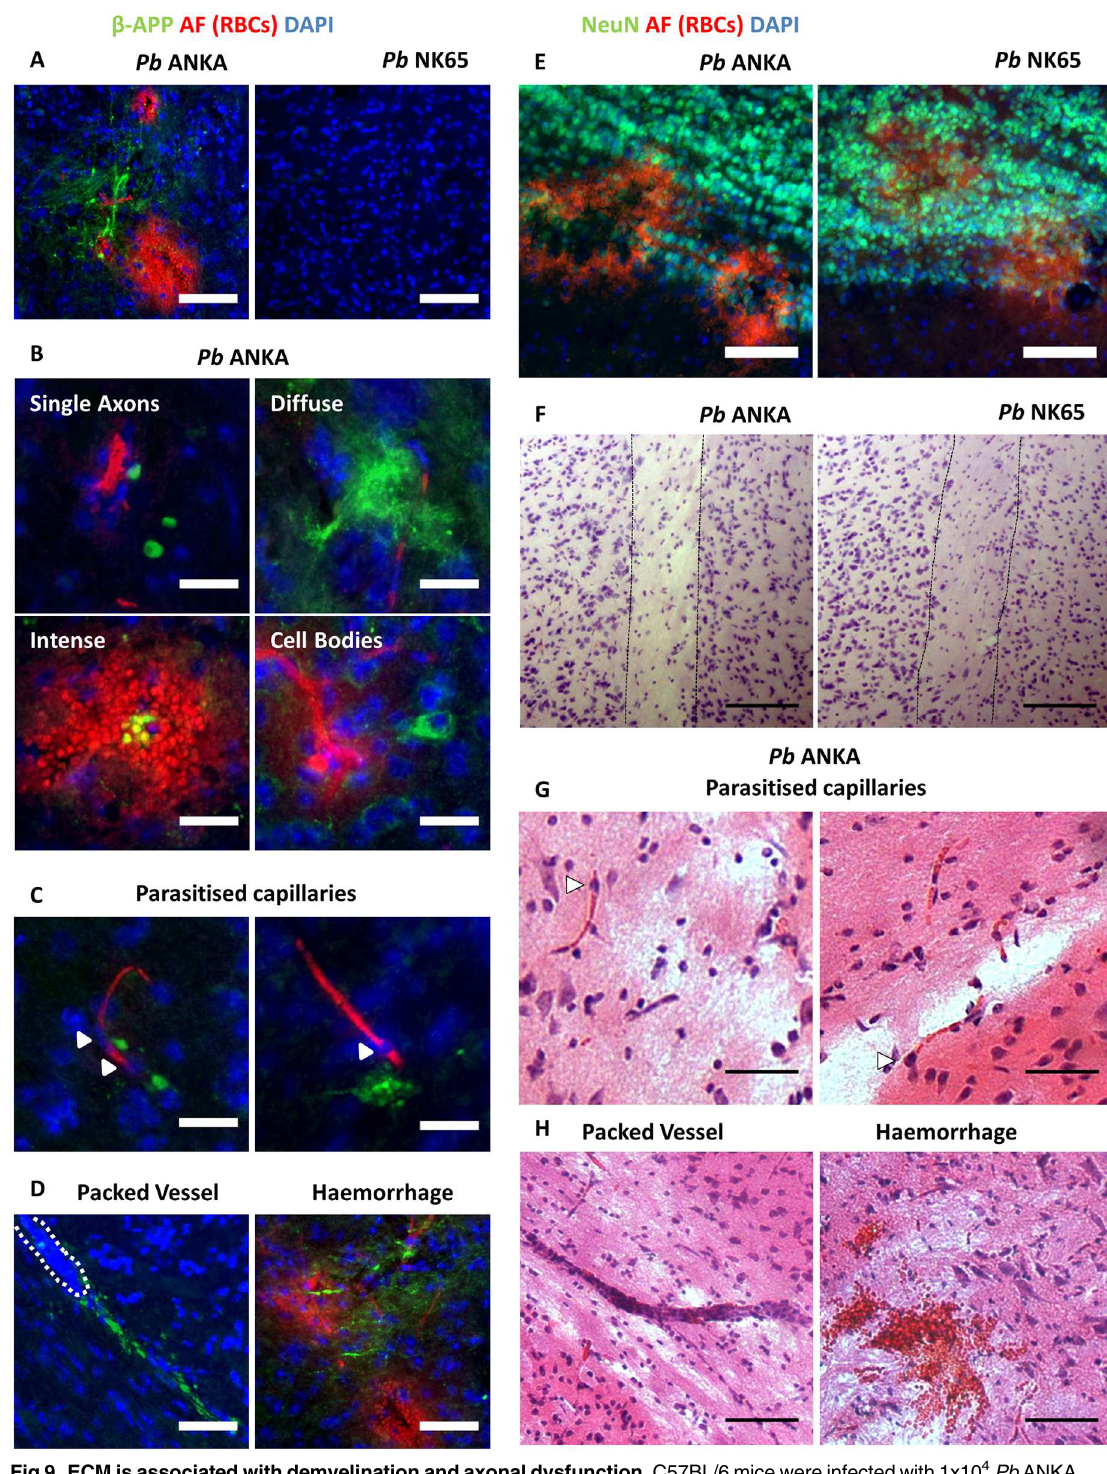
Fig 9. ECM is associated with demyelination and axonal dysfunction. C57BL/6mice were infected with 1x10 4 Pb ANKA GFP (n = 7) or 1x10 4 Pb NK65 GFP (n = 5) pRBCs. Mice were culledat d7 p.i. when Pb ANKA infected mice exhibitedsigns of late-stage ECM. Brains were removedfrom transcardiallyperfusedmice and processedfor immunofluorescent and histological examination. (A) Representative images show presenceand absence,respectively,of β -APP (green)accumulationwithin white matter tracts (Pons) during Pb ANKA and Pb NK65 infection. Cell nuclei are blue and auto-fluorescent (AF) RBCs red.